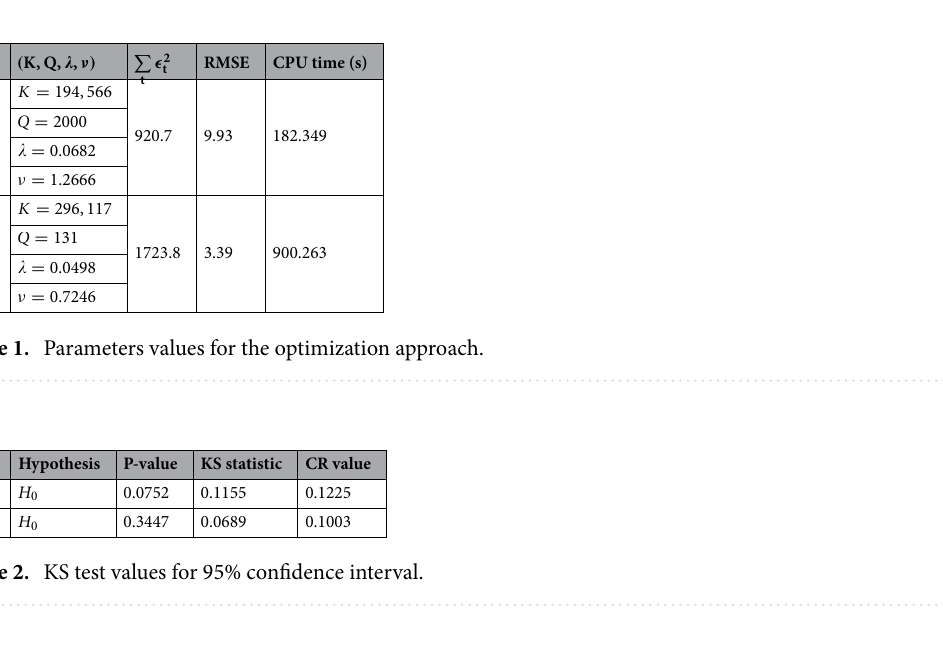
Figure 1. Estimate cumulative number of deaths curves.